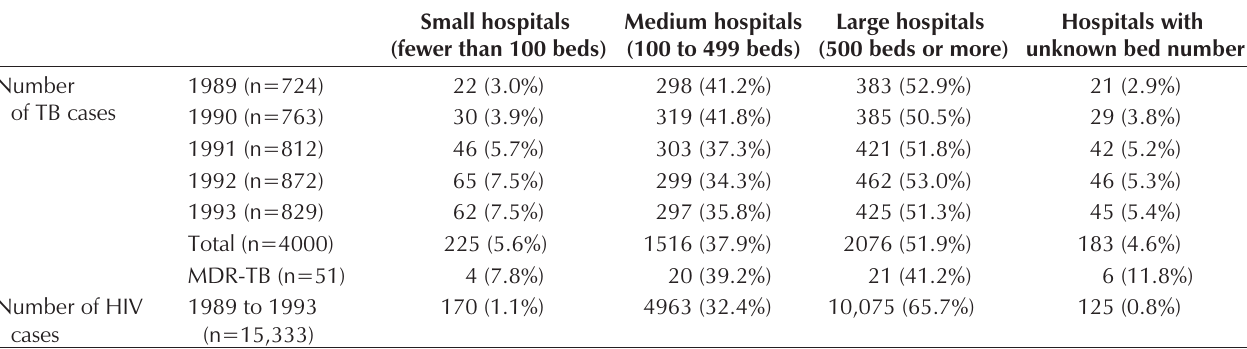
Number of tuberculosis (TB) and human immunodeficiency virus (HIV) cases admitted to small, medium and large acute care hospitals